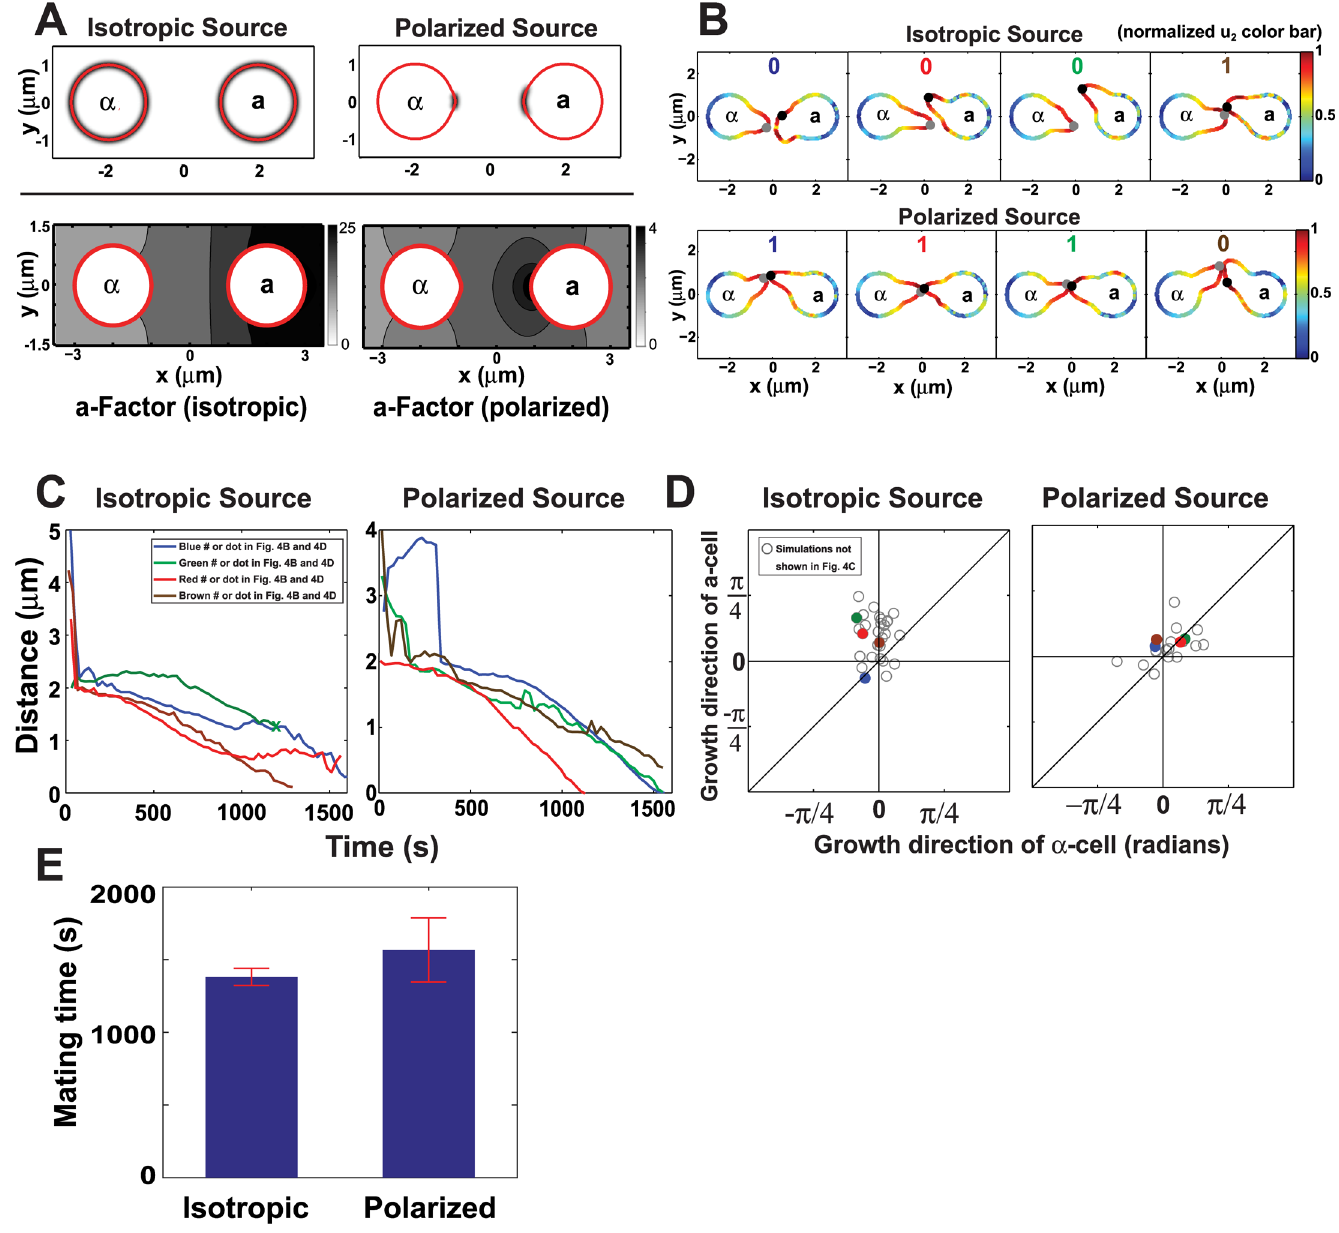
Fig 4. Mating efficiency of isotropic versus polarized pheromone source. (A) Schematic diagram of isotropic versus polarized (non-isotropic) pheromone source. Top row indicates in black shading the spatial distribution of the pheromone source function. The bottom row depicts the a -factor diffusion profile shown as a concentration contour plot for the isotropic source (left) and the polarized source (right). (B) Polarization plots of u 2 showing mating cells at end of simulation. Four sample simulations each from the isotropic source group and from the polarized source group are shown. The normalized level of u 2 is color coded on the surface of the cell according to the colormap on right. The polarisome is denoted by the black or gray dot at the projection tip. The polarized source produces higher mating efficiencies; the 1 or 0 indicates a successful or unsuccessful mating. The polarization plots, distance plots, and direction plots are color coded (blue, red, green, brown) for a particular simulation. (C) Distance plots for each of the four simulations. These plots show the distance between polarisomes of the mating partners as a function of time. With the isotropic source, the distances do not converge to 0 for some of the simulations. The green isotropic source simulation was terminated early because it did not meet the distance/direction threshold. (D) Direction plots for polarized source and isotropic source simulations. Each data point represents the averaged direction of the projection from each cell during mating. Axes are described in the legend to Fig 3C. Mating is more likely if the projections are in the same direction i.e. along the diagonal in the top right or bottom left quadrants. The average distance from the diagonal is 0.26 radians for the isotropic source compared to 0.12 for the polarized source matings. Colored filled circles correspond to simulations shown in (B) and (C). (E) Average mating time of successful matings with isotropic and polarized